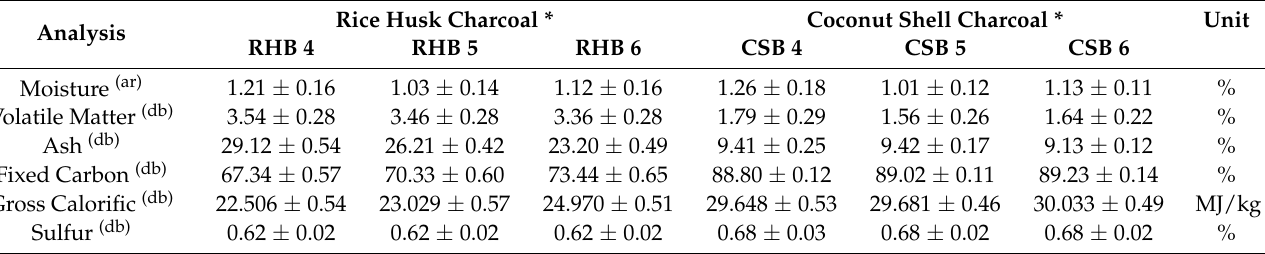
Table 4. Biocoke